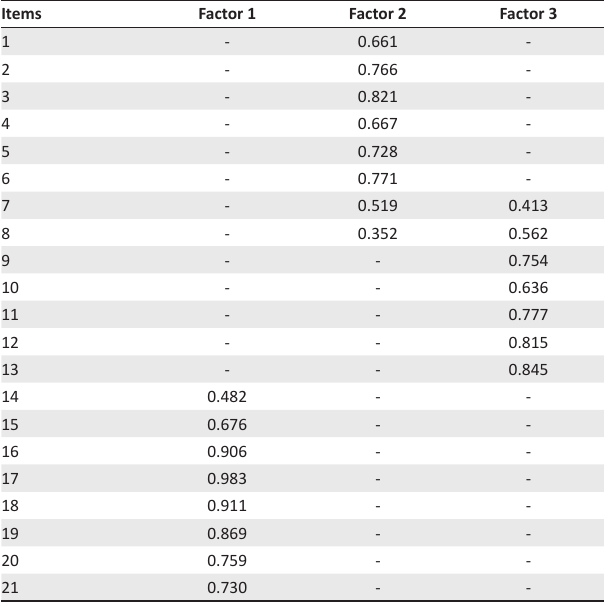
TABLE 2: Rotated loading matrix.